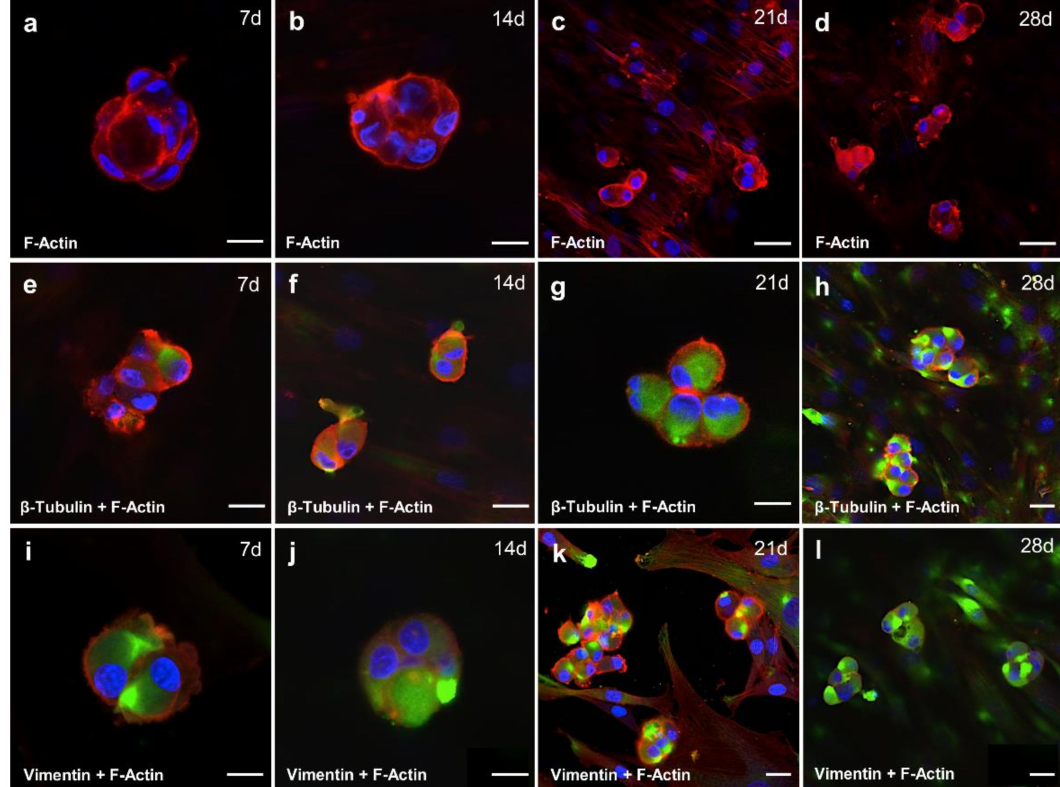
Figure5. CytoskeletalelementsandarrangementinspheroidsproducedontheRPM.( a )F-Actinstaining of spheroids produced during 7 d, ( b ) 14 d, ( c ) 21 d and ( d ) 28 d cultivation. ( e ) Immunofluorescence staining (IFS) of tubulin together with F-actin of spheroids produced during 7 d, ( f ) 14 d, ( g ) 21 d and ( h ) 28 d cultivation on the RPM. ( i ) IFS of vimentin together with F-actin of spheroids produced during 7 d, ( j ) 14 d, ( k ) 21 d, ( l ) and during 28-day-cultivation on the RPM. Scale bars = 20 µ m; red (rhodamine-phalloidin): F-actin, blue: Hoechst dye 33342-stained nuclei, green (FITC): tubulin or